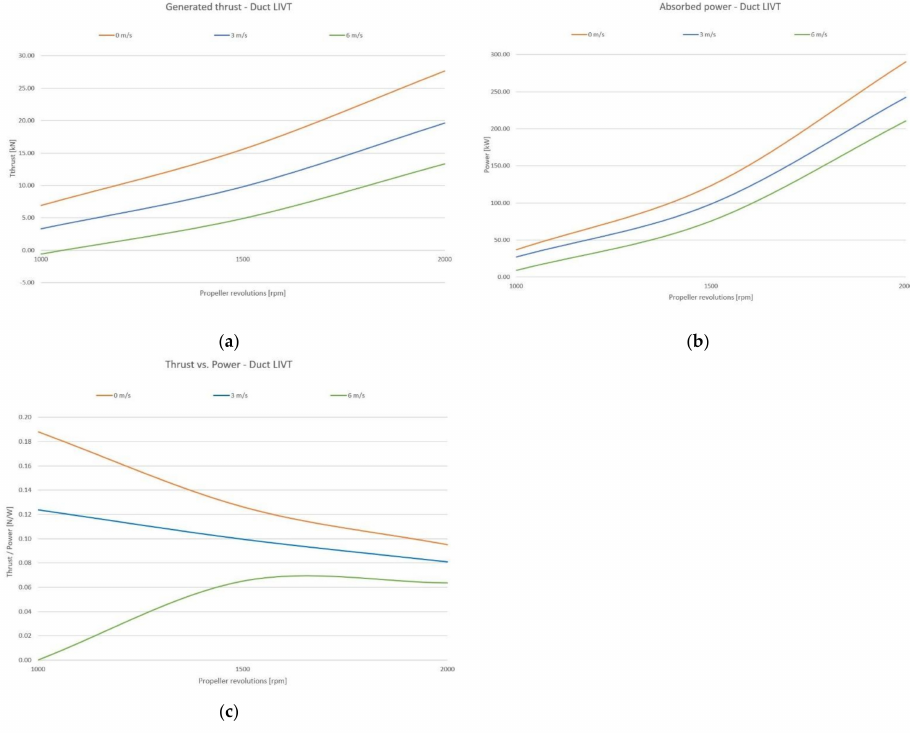
Figure 10. Performance characteristics of propeller with LIVT duct. ( a ) Generated thrust for different speeds depending on the propeller speed; ( b ) absorbed power for different speeds depending on propeller speed; ( c ) generated thrust per unit of power